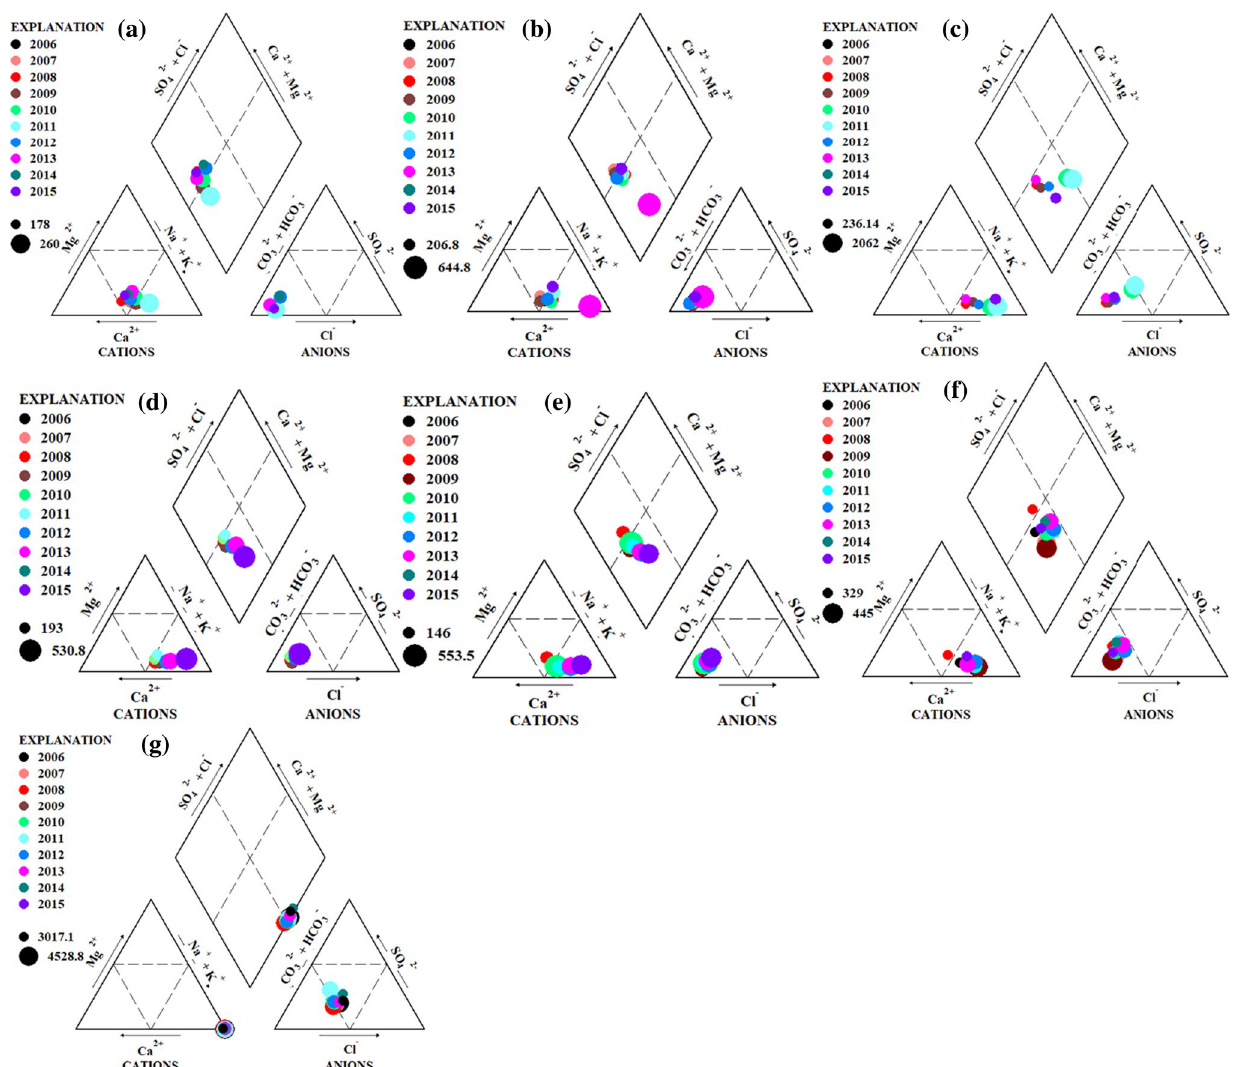
Fig. 3 Piper diagrams of the Awash River water at a Wonji, b AR_B_LB, c AR_A_LB, d AWS, e MS, f and Dubti, and g the Lake Beseka. The sizes of the symbols refer to the extents of TDS values in